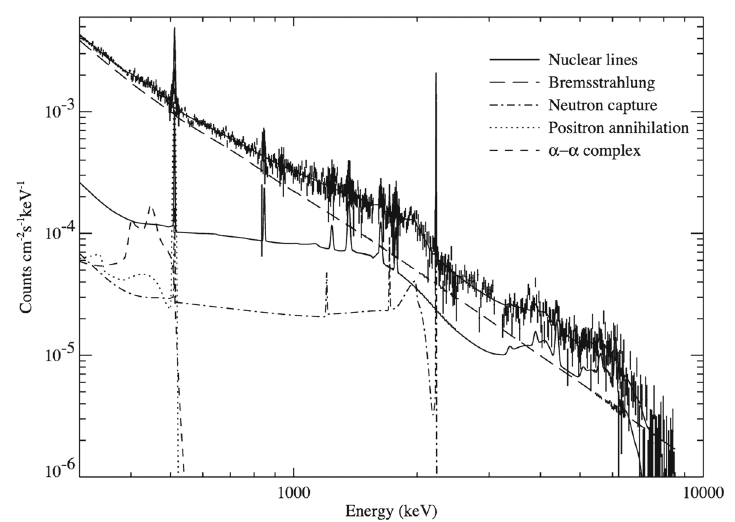
Fig. 22 RHESSI gamma-ray spectrum from 0.3 to 10 MeV integrated over the duration of the flare SOL2002-07-23. The lines show the different components of the model used to fit the spectrum. Image reproduced by permission from Lin et al. (2003), copyright by AAS